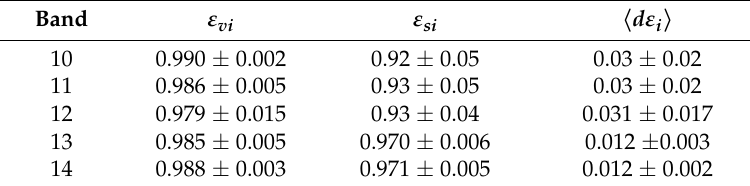
Table 5. Emissivity of vegetation ( ε vi ), soil ( ε si ) and cavity term ( (cid:104) d ε i (cid:105) ) to be used in the Vegetation Cover Method (VCM) for the different ASTER TIR channels (see Equation (9)). The indicated uncertainties correspond to the standard deviation of the emissivity values for all the considered